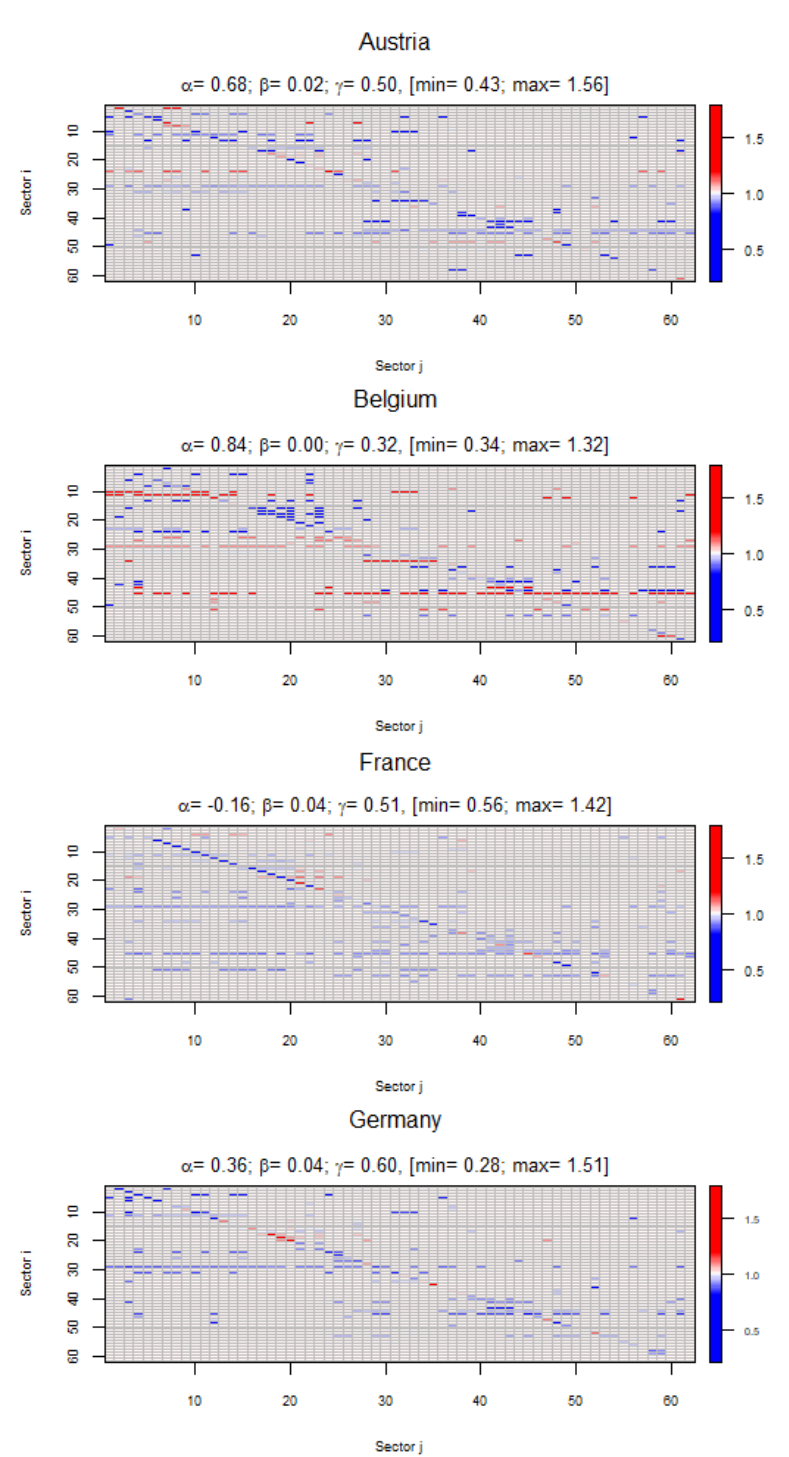
Figure 7. Errors in technical coefficients via extended 2D- LQ for EA-19 countries. Source: internal based on Eurostat data [naio_10_cp1700].